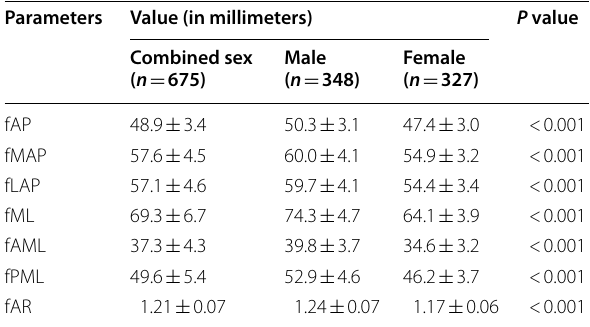
Table 3 Morphometric measurements of the distal femur